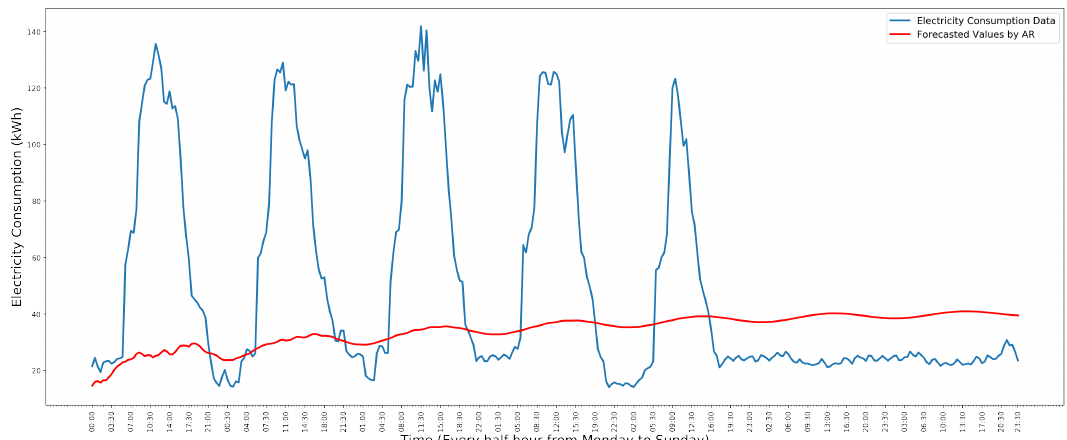
Figure 2. Comparison of the 30th week’s electricity consumption data and the predicted